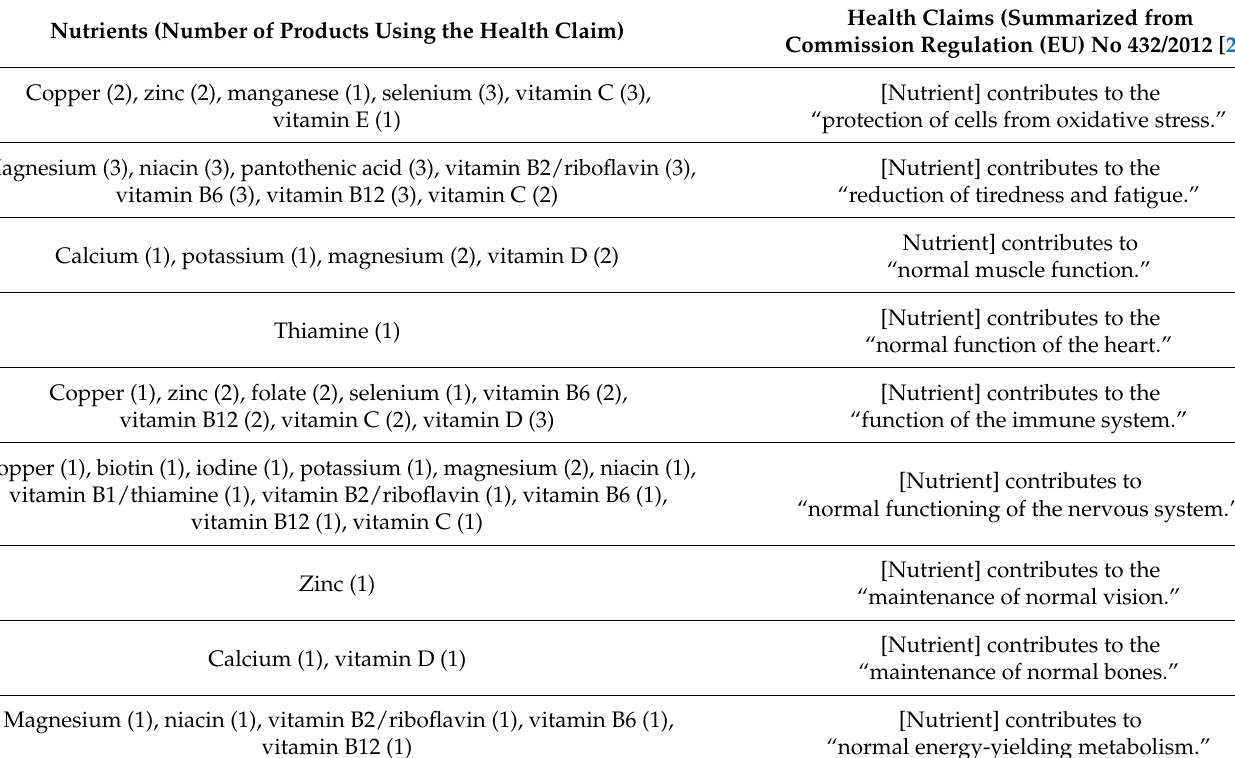
Table 3. Health claims on food supplement labels grouped according to the related